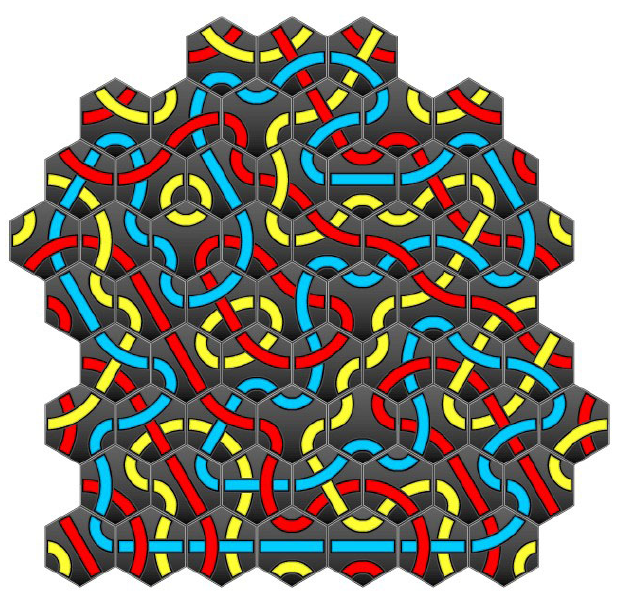
A Tantrix solution of challenge number 60, which is obtained by solving IP